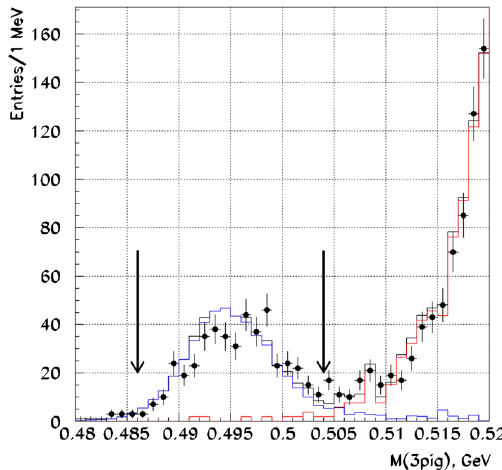
Fig. 5 The invariant mass distribution of the 3 πγ system for the data (black circles), the signal decays (blue histogram), the main sources of the background (red histogram) and the sum of the contributions of the signal decays and the background (black histogram). The arrows show the signal region used in the analysis